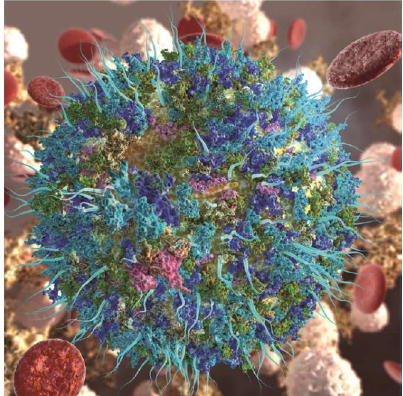
Figure 7. A nanoparticle gains a new biological identify upon its dynamic interactions with biological fluids, giving rise to a protein corona (shown as adsorbed green, blue, and cyan globules), which consequently influences drug delivery and the targeting of functionalized nanoparticles (illustrated as aqua blue fibrils), reproduced with permission from [86], published by American Chemical Society, 2017.